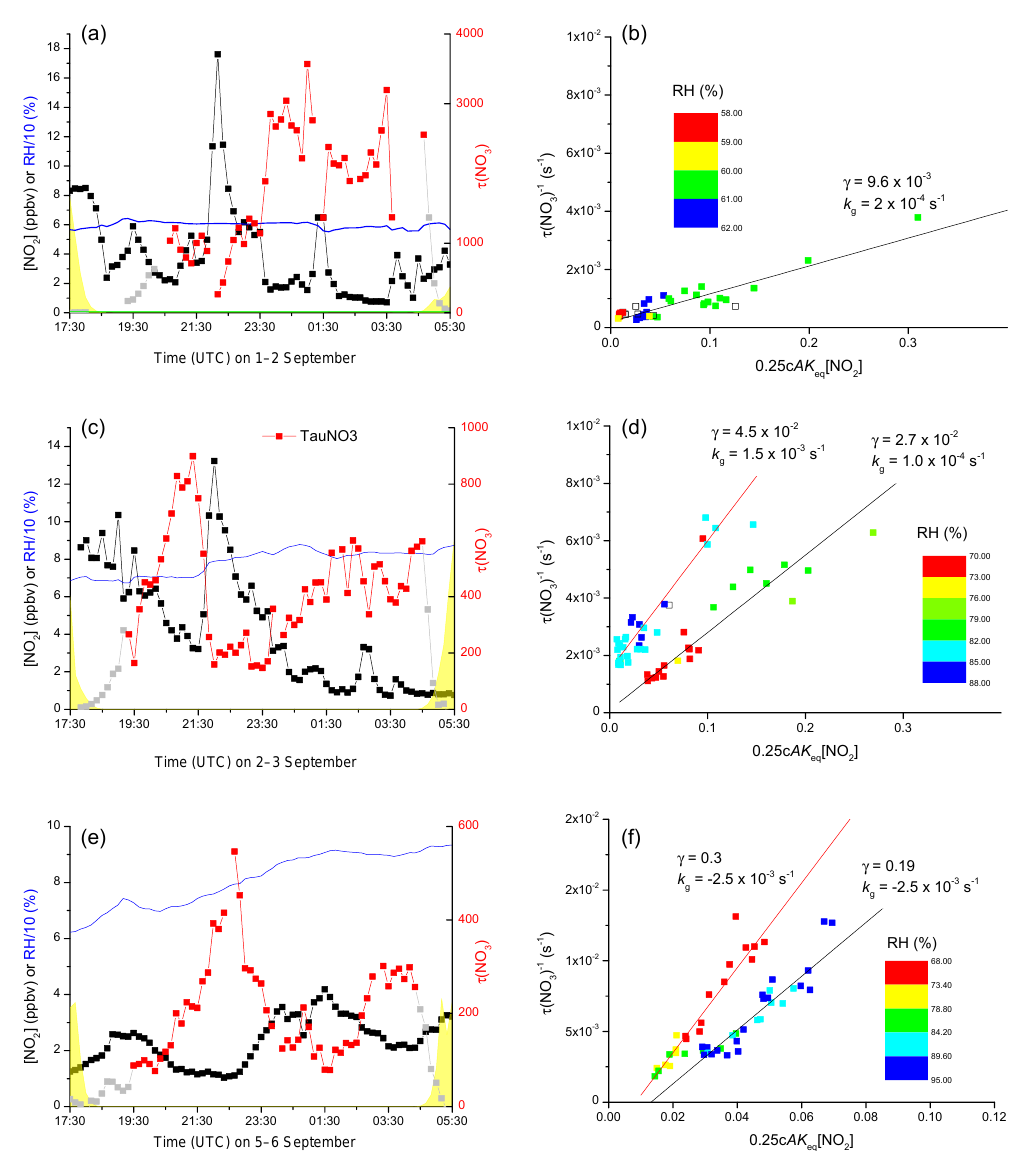
Figure 9. Derivation of γ via analysis of NO 3 steady-state lifetime variation with NO 2 . The grey τ (NO 3 ) data points were not considered in the analysis as NO 3 will not always be in steady state in the first hours after sunset or during